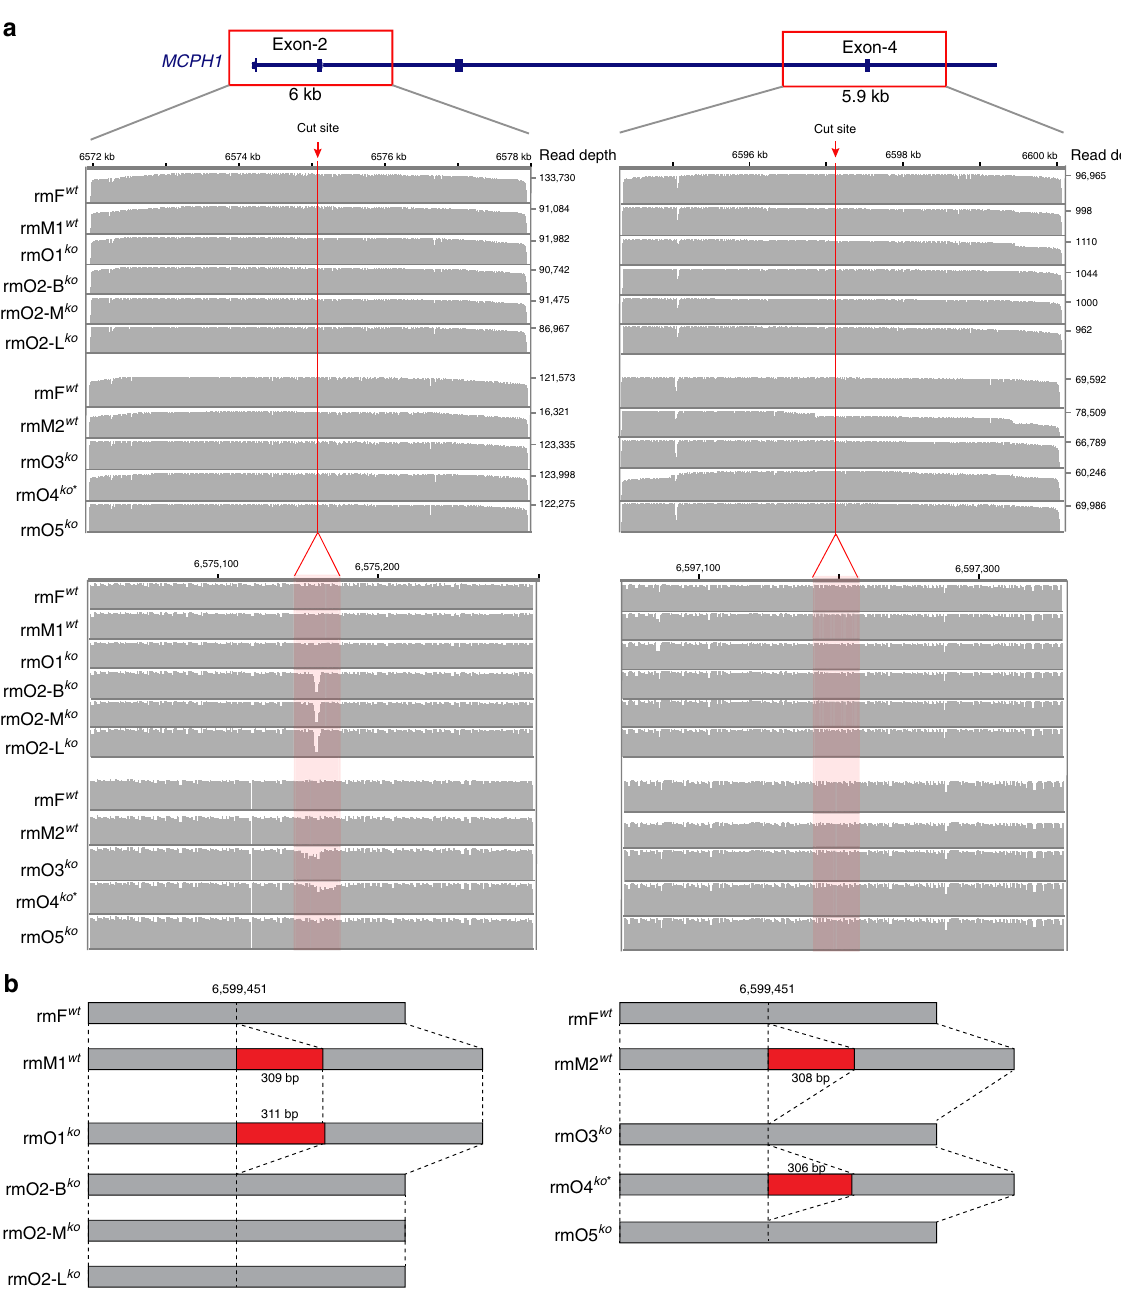
matched recipients. A total of six monkeys were used as surrogate recipients, and typically, four embryos were transferred for each recipient female. The earliest pregnancy was diagnosed by ultrasonography about 30 days after transfer. Both pregnancy and number of fetuses were con fi rmed by fetal cardiac activity and presence of a yolk sac as detected by ultrasonography.